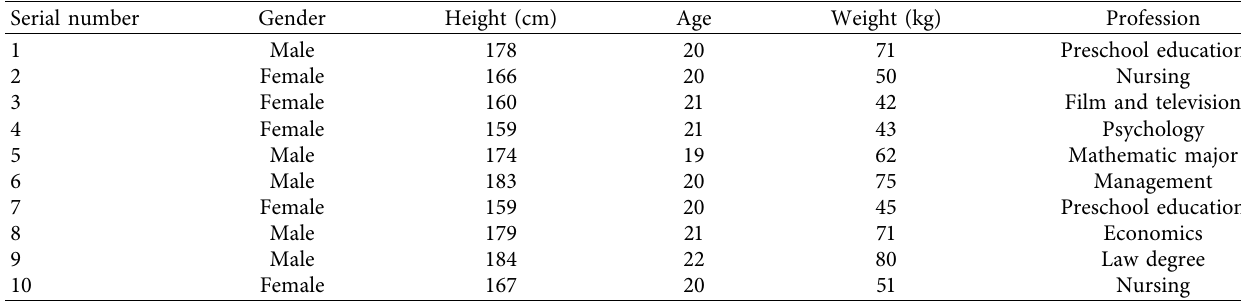
Table 1: Student data collection form.